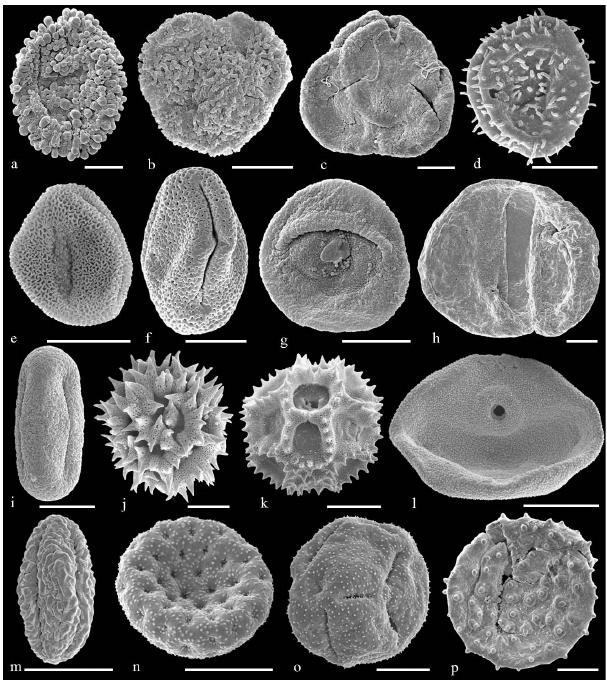
Fig. 3. Floristic turnover in Iceland as illustrated by characteris- tic pollen types from the 15–0.8Myr sedimentary rock formations. (a–h) Pollen of predominantly woody, warmth-loving plants, 15 and 12 Myr. (a) Ilex sp., 12Myr. (b) Viburnum sp., 12Myr. (c) Rhododendron aff. ponticum L., 12Myr. (d) Lemna sp., 12Myr. (e) Platanus subgenus Platanus , 15Myr. (f) Parthenocissus sp., 15Myr. (g) Sequoia sp., 15Myr. (h) Cathaya sp., 15Myr. (i–p) Pollen of herbaceous plants, 10Myr and younger formations. (i) Apiaceae, 10Myr. (j) Asteraceae, 10Myr. (k) Asteraceae, 1.1Myr. (l) Poaceae, 0.8Myr. (m) Fragaria sp., 1.7Myr. n. Chenopodium sp., 10Myr. (o) Ranunculus sp., 10Myr. (p) Valeriana sp.,